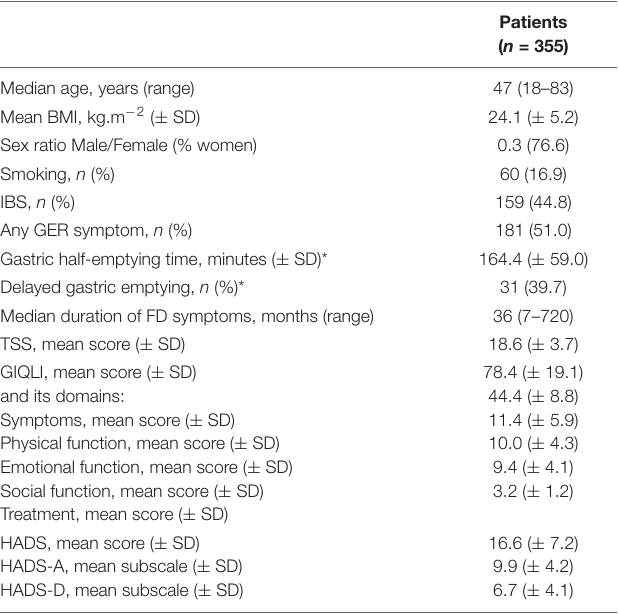
TABLE 1 | Patient characteristics of the overall population.